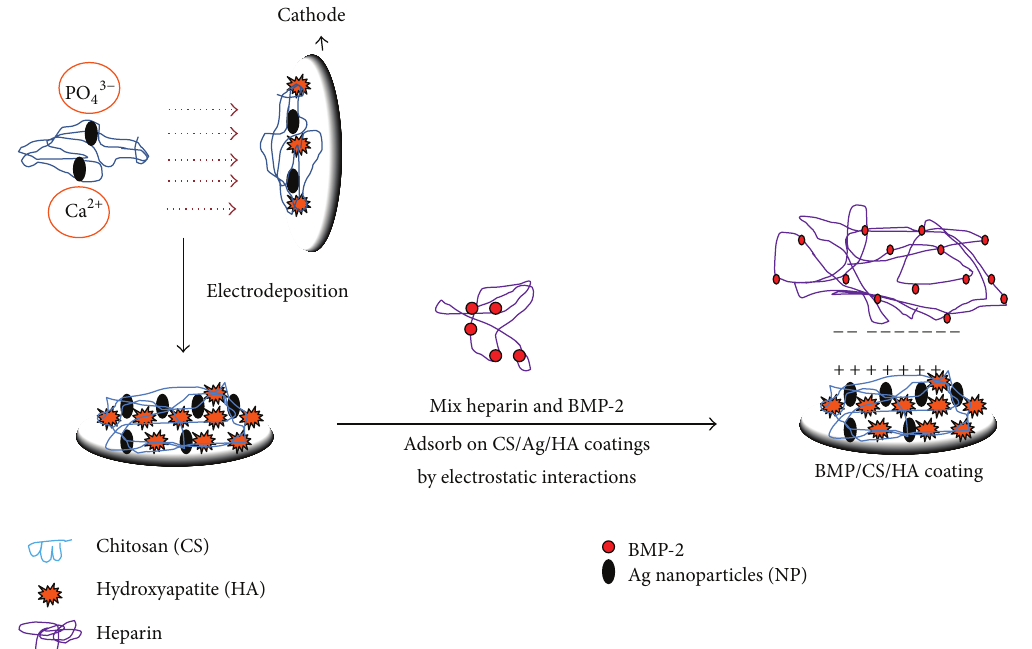
Figure 7: Titanium surface modified with growth factors, HA chitosan, and Ag-NPs. Reproduce from Xie et al. with permission from ACS publishers